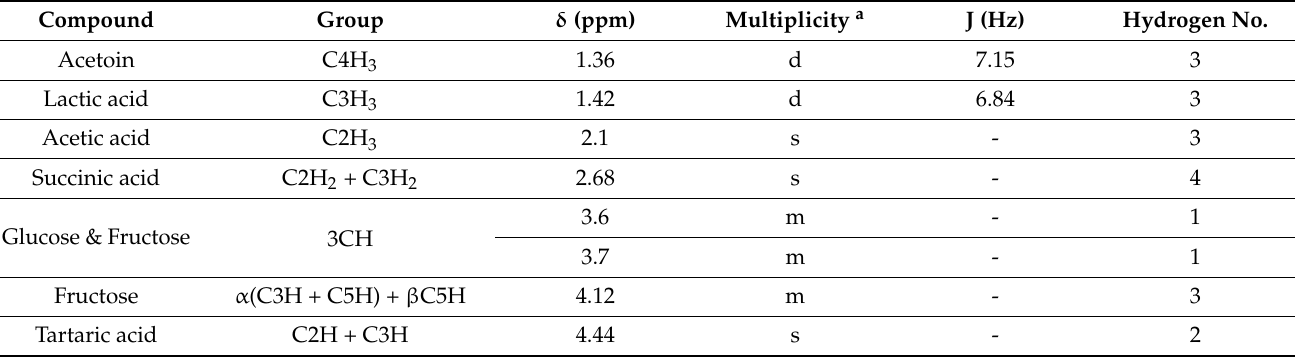
Figure 7. The 1H NMR Spectrum of the produced date vinegar V15. Table 5. 1H NMR chemical shifts and characteristics signals of compounds in vinegar